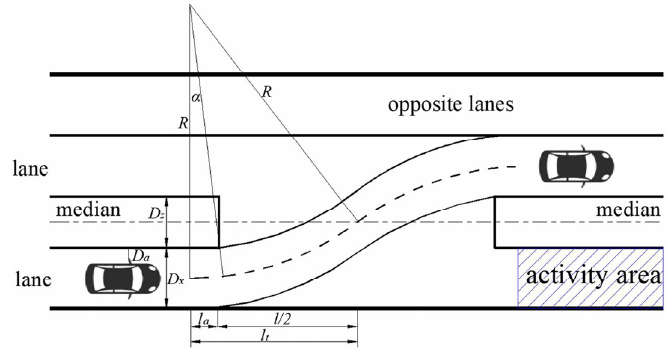
Figure 1. Schematic diagram of the median opening length calculation model.